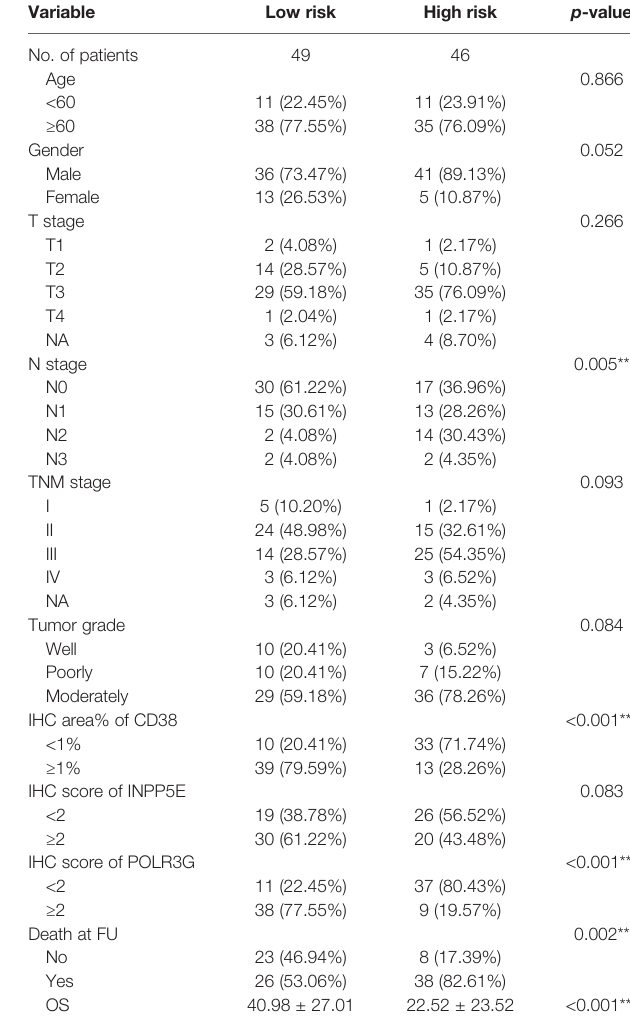
TABLE 1 | The clinicopathological characteristics strati fi ed by prognosis signature in 49 ESCC patients. Variables Low risk